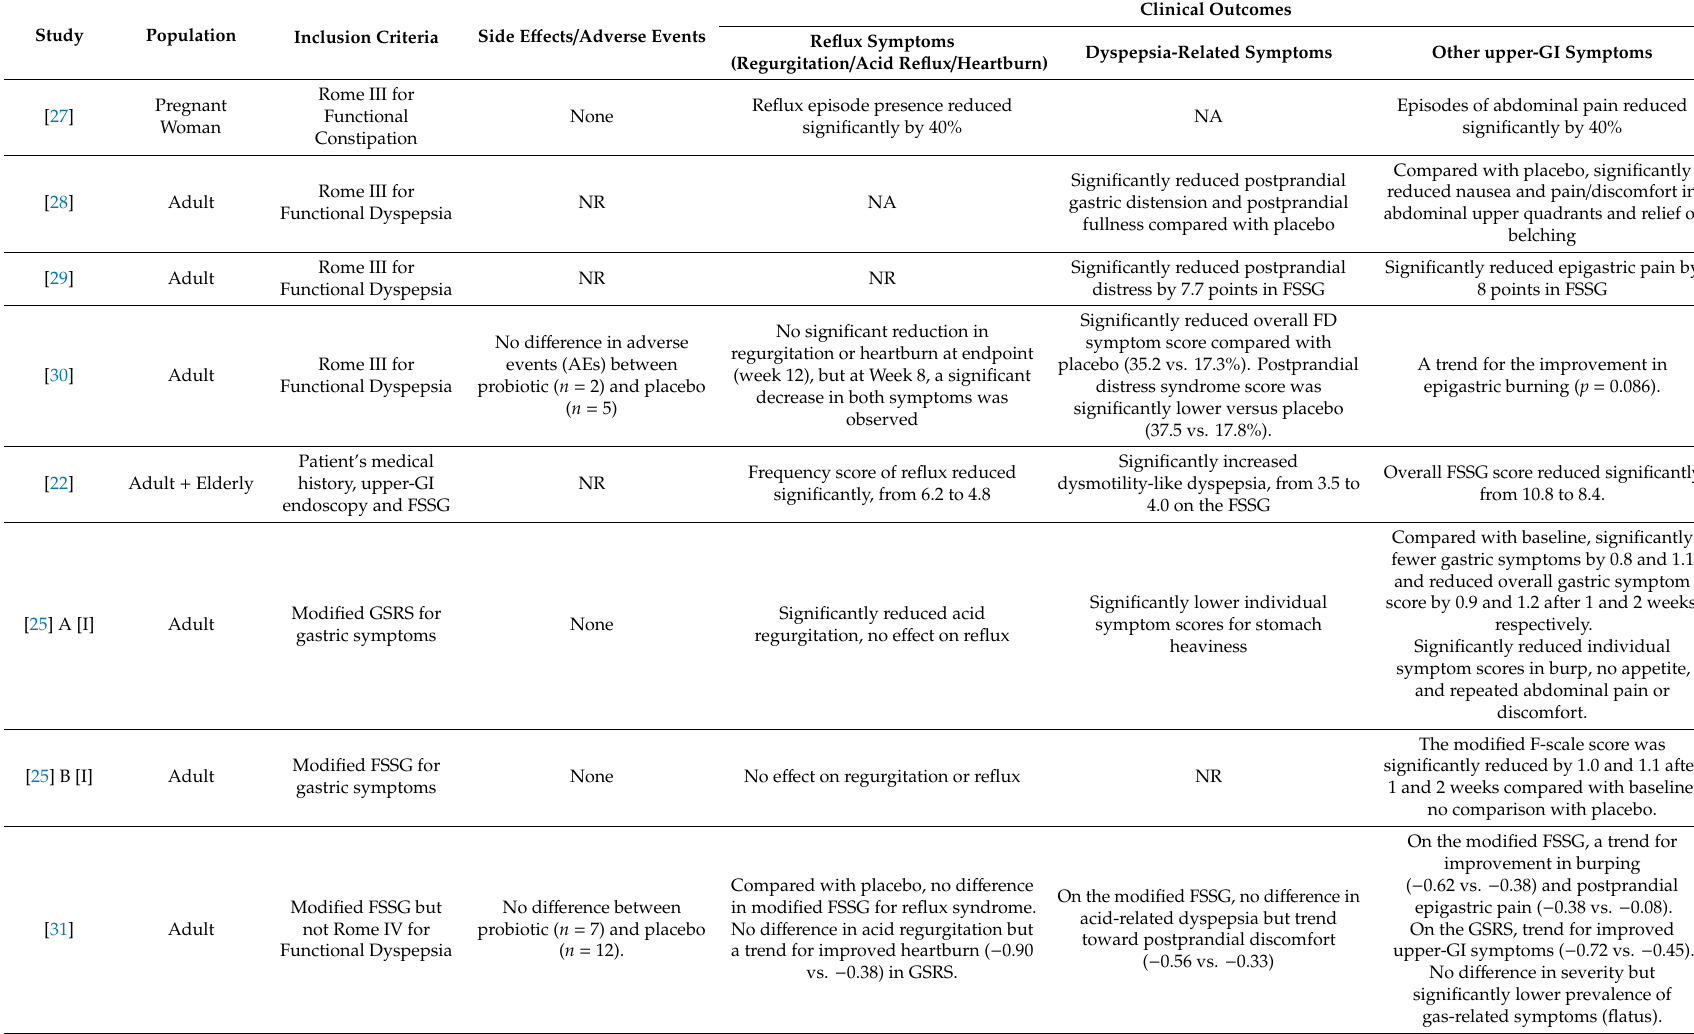
Table 3. Study Design and Clinical